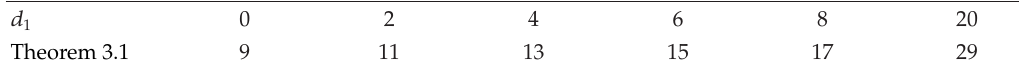
Table 1: Allowable upper bound of d 2 with given d 1 .